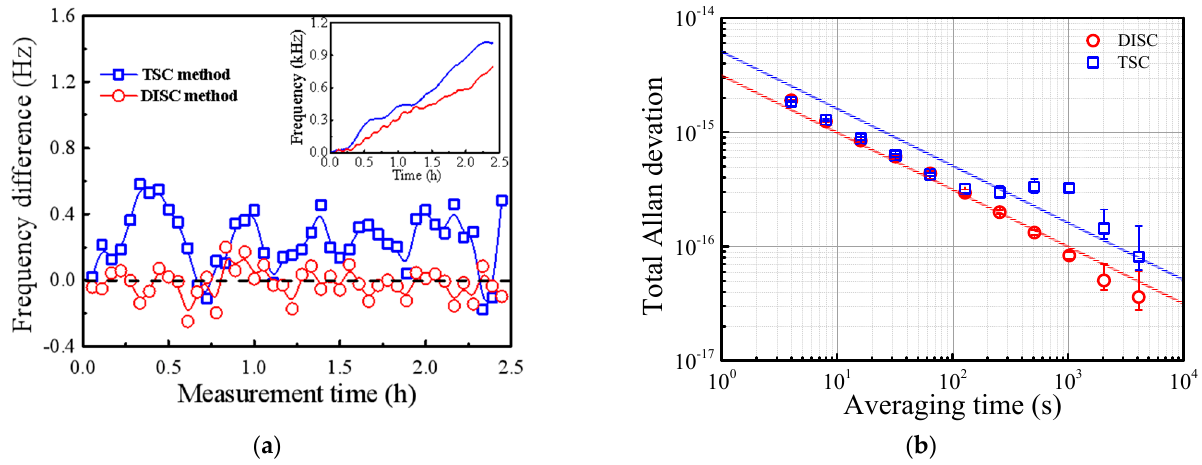
Figure 2. ( a ) Comparison of the traditional self-comparison and the drift-insensitive self-comparison methods. Red circles are measured using the drift-insensitive self-comparison method, the blue squares are obtained using the traditional self-comparison method, and the black dashed line indicate zero frequency difference. Each experimental data point is the average value over 200 s measurement time, and the inset shows the clock laser frequency corrections over the self-comparison process (the blue and red lines correspond the traditional self-comparison and the drift-insensitive self-comparison methods, respectively). ( b ) Comparison of self-comparison instabilities. The blue squares indicate the instability of the traditional self-comparison method and the red circles represent the instability of the drift-insensitive self-comparison method. The error bars correspond to 1 σ standard deviation and the solid lines are the linear fitting with a fixed slope of − 0.5. The instability falls again above 10 3 s due to the approximately linear drift in the whole process.